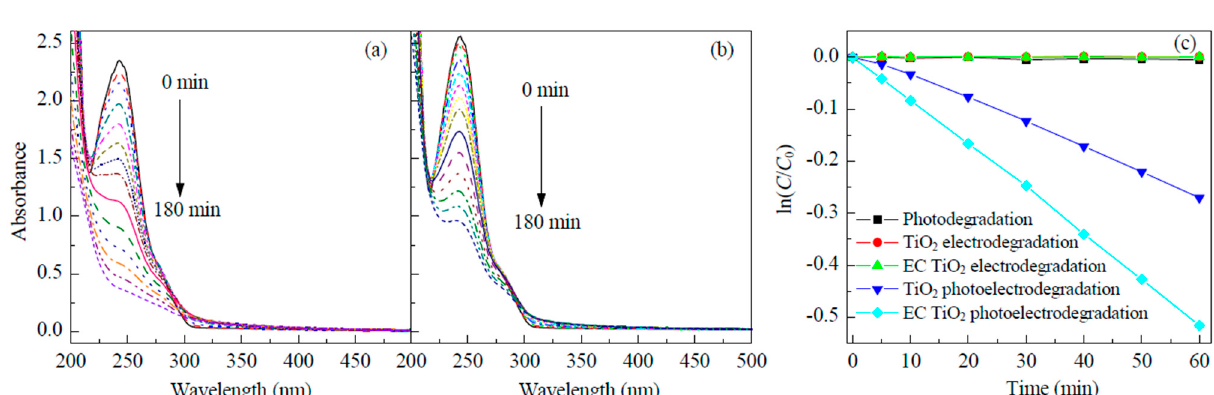
Figure 3. Absorbance spectra for the photoelectrochemical degradation of 40 mg·L -1 of acetaminophen in 0.1 mol/L Na 2 SO 4 at treated ( a ) and untreated ( b ) TiO 2 nanotube electrode with a potential of 1 V. ( c ) Plot of ln ( C / C 0 ) versus time of the degradation of acetaminophen by different means. Reproduced with permission [53].